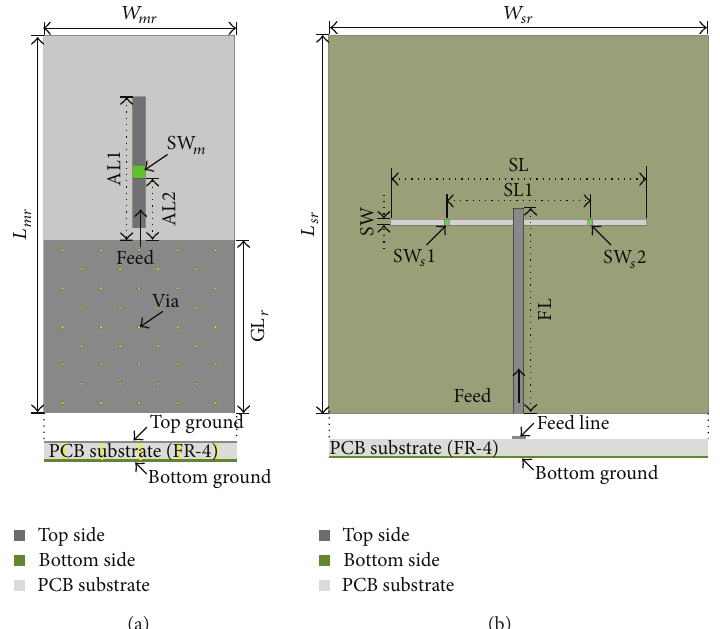
Figure 5: Geometry of the reconfigurable antennas with RF switches; (a) the monopole antenna (left) and (b) the slot antenna (right).